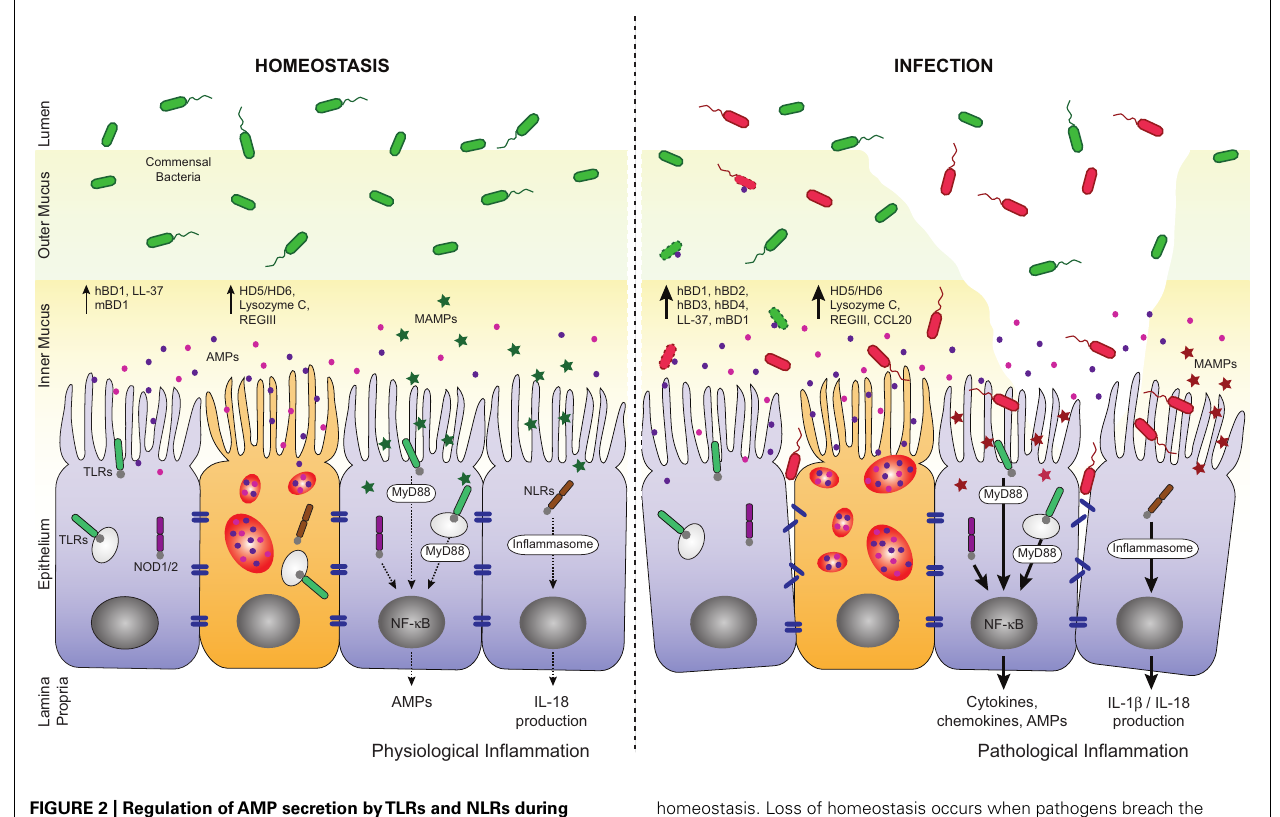
homeostasis. Loss of homeostasis occurs when pathogens breach the mucus layer, enter in contact with IECs and disrupt the epithelial barrier integrity. Pathogens and their products (MAMPs, red stars) are also sensed by PRRs and induce MyD88- or inflammasome-dependent expression of a pro-inflammatory and antimicrobial program. In consequence, high levels of AMPs and cytokines/chemokines are produced that help limit pathogen propagation and contribute to the recruitment of immune cells. hBD, human β -defensin; mBD, mouse β -defensin; HD, human α